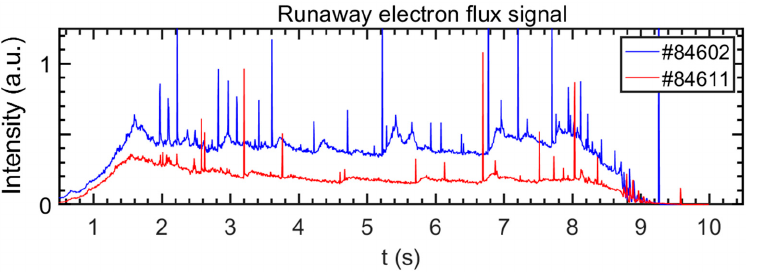
11 of 16 Figure 7. Time traces of spectral lines intensity with lithium granule injection (#84607, recovery dis ‐ charge). ( a ) Li II 199.28 Å, He II 303.78 Å, O III 374.0 Å, and C IV 312.4 Å, ( b ) O IV 238.57 Å, O V 215.245 Å, and O VI 184.117 Å, ( c ) C V 40.268 Å, O VII 21.6 Å, C VI 33.734 Å, and O VIII 18.97 Å, ( d ) runaway electrons and ECE signal. Lithium granule entered plasma at t = 3.6 s in this discharge.